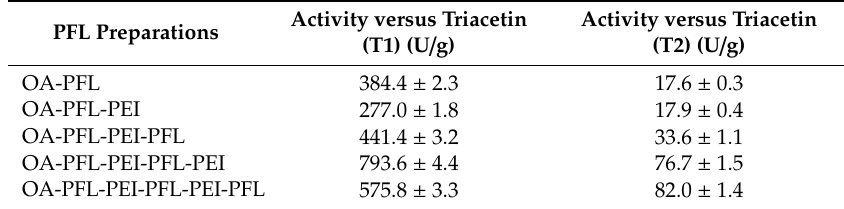
Table 2. Mass activity of di ff erent PFL biocatalysts in hydrolysis of 50 mM triacetin at pH 5. Activity is given in micromoles of acetic acid released per minute and gram of biocatalysts. T1: 25 ◦ C. T2: 4 ◦ C in the presence of 30% acetonitrile (v / v). Experiments were carried out as described in